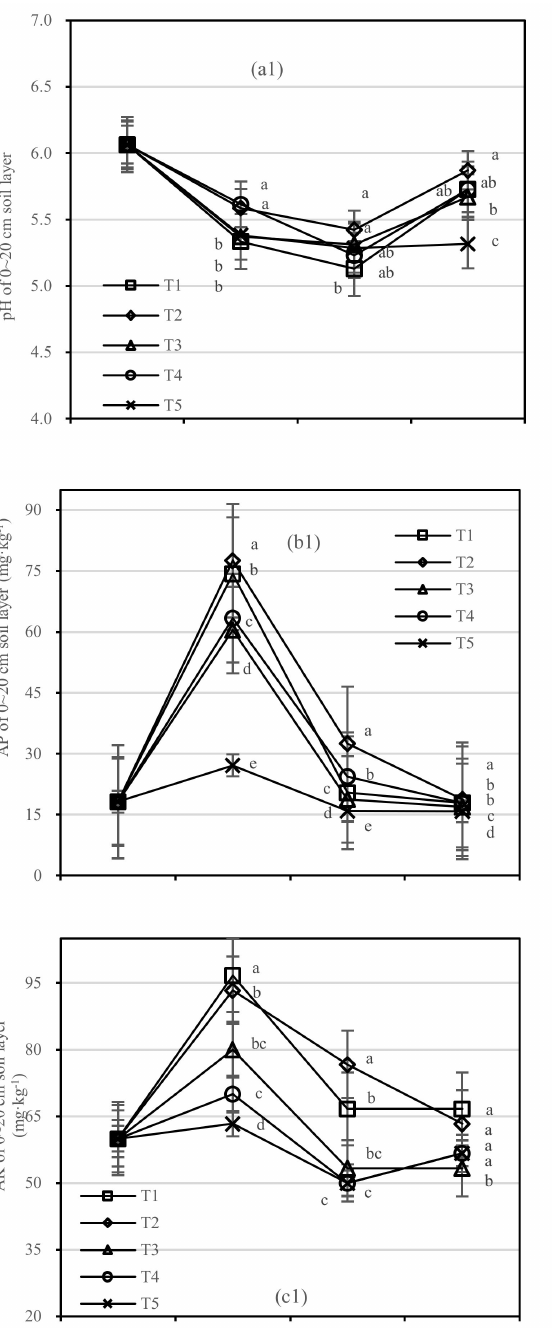
Figure 3. Soil pH, AP, and AK in four periods under five fertilization types. Data are the mean content ± standard deviation. Letters represent differences ( α = 0.05). T1: adjustment of C/N and C/P + 0.2% priming; T2: adjustment of C/N and C/P + 0.2% common compost; T3: adjustment of C/N and C/P; T4: raw material grinding of thinning shreds; T5: no fertilization. Additionally, ( a1 , a2 ), ( b1 , b2 ) and ( c1 , c2 ) describe the contents of soil pH value, available phosphorus (AP), and available potassium (AK) at 0–20 cm and 20–40 cm,